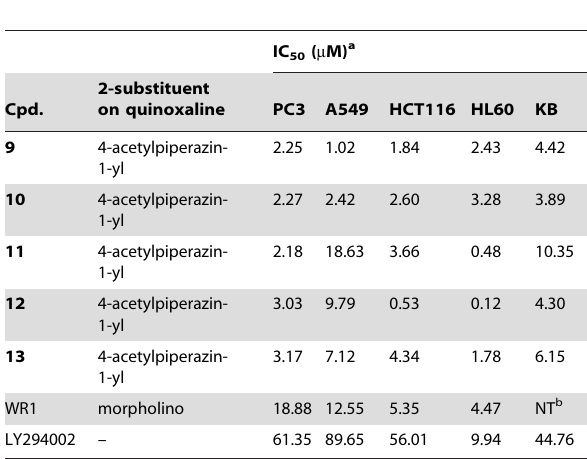
Table 1. Antiproliferative activity of piperidinylquinoxalines